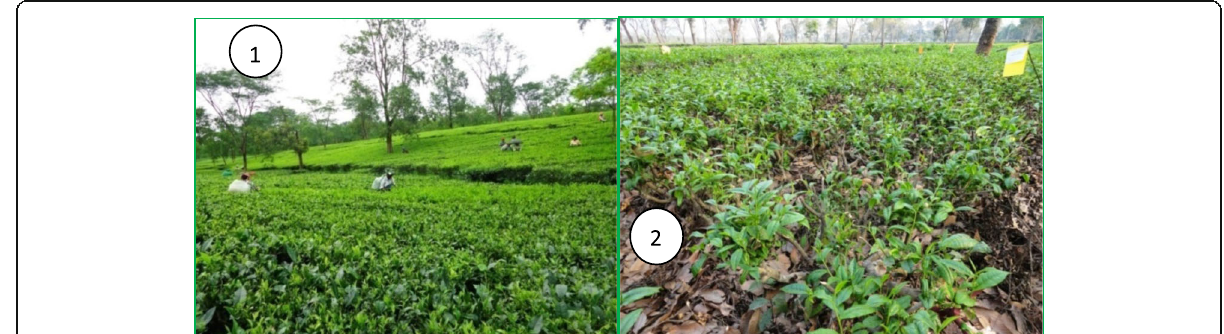
Fig. 2 View of Trichoderma applied fields. 1 Foliar spray and 2 Post prune